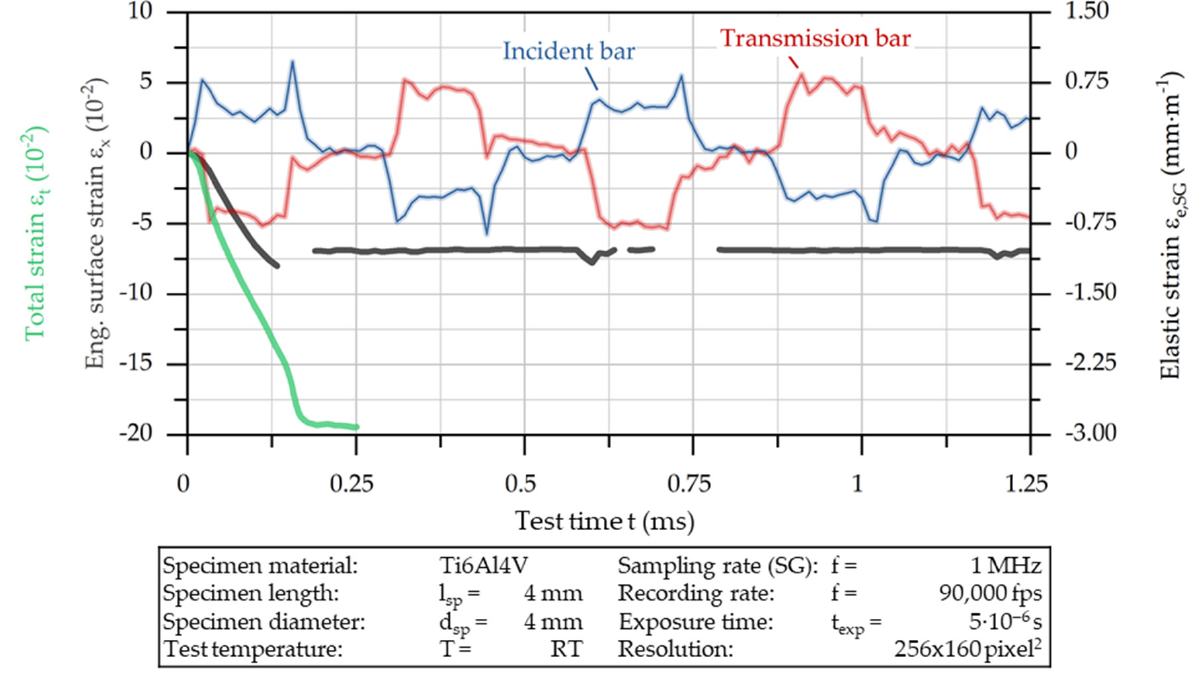
Figure 8. Strain response of AISI 1045.